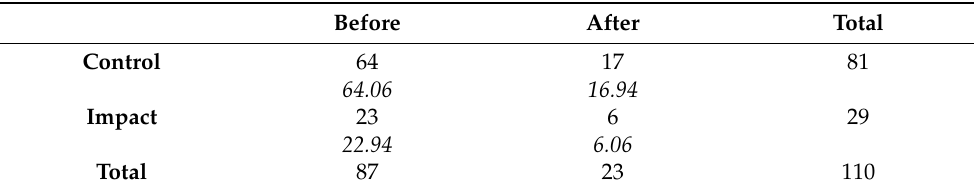
Table 1. Observed frequency of roadkills of bare-nosed wombats ( Vombatus ursinus ) in the control and impact road sections before and after installation of a virtual fence. Data from Table 1, Supplementary Data of Stannard et al. [7]. Expected frequencies (in italics) from the null hypothesis of no association between treatment ( control/impact ) and time ( before/after ). Before After